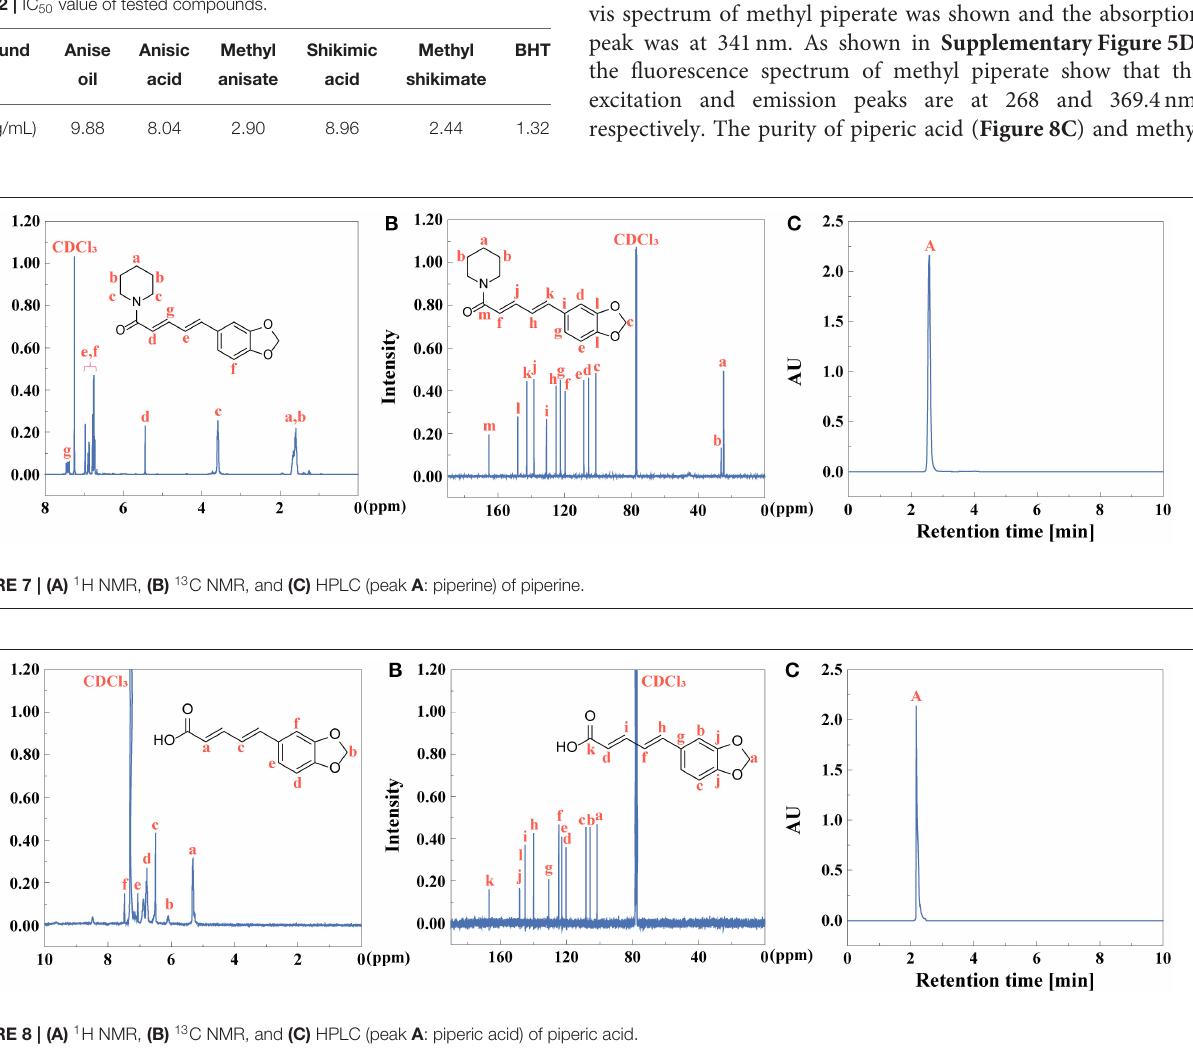
Frontiers in Chemistry |